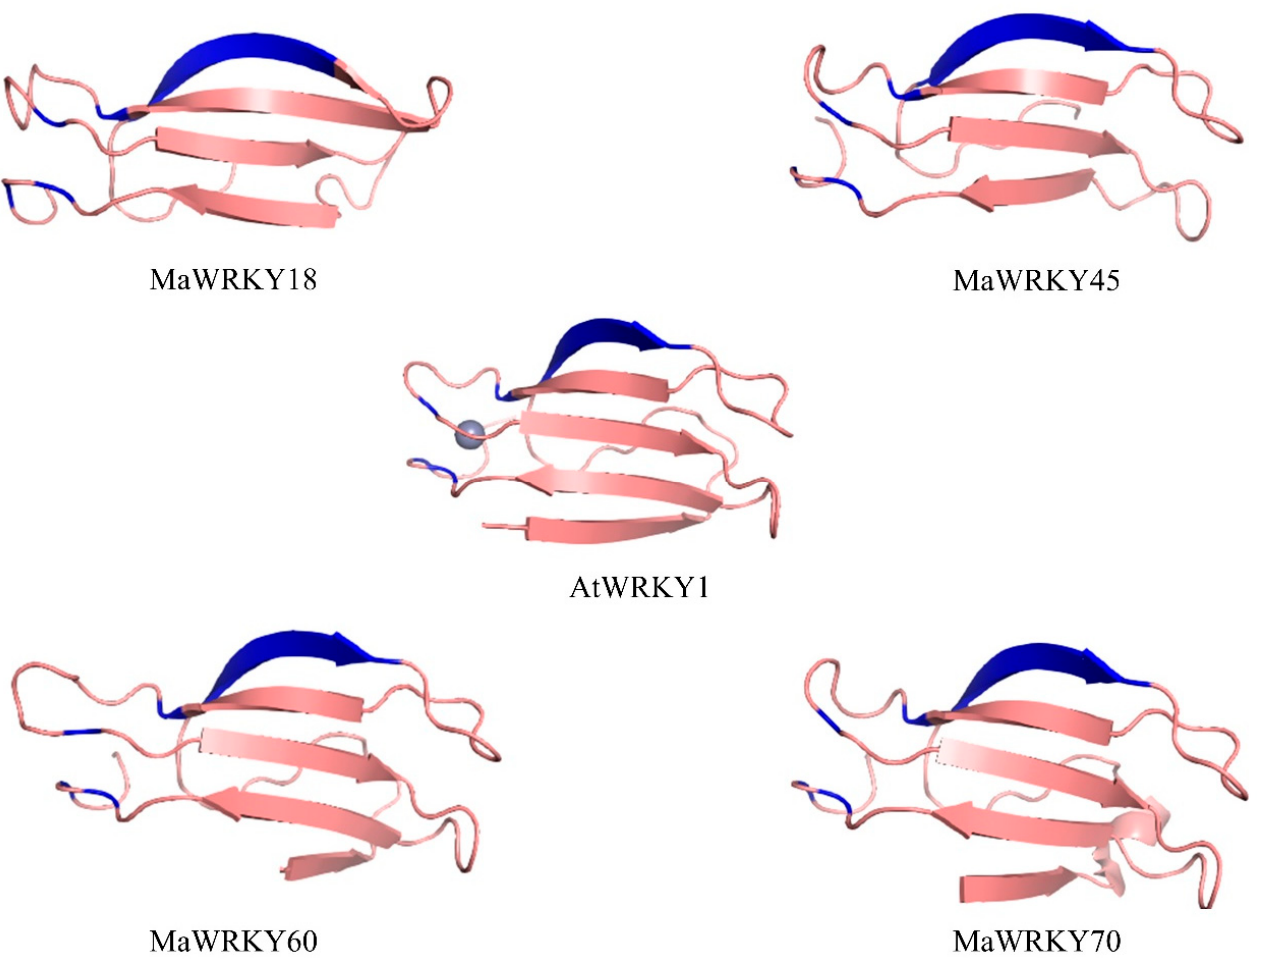
Figure 3. 3D ribbon cartoon view of the WRKY domain of MaWRKY18, MaWRKY45, MaWRKY60, and MaWRKY70. The WRKYGQK β -sheets and the zinc-finger motifs are shown in blue. The zinc ion is presented for the Arabidopsis AtWRKY1 3D model (PDB accession code 2AYD).